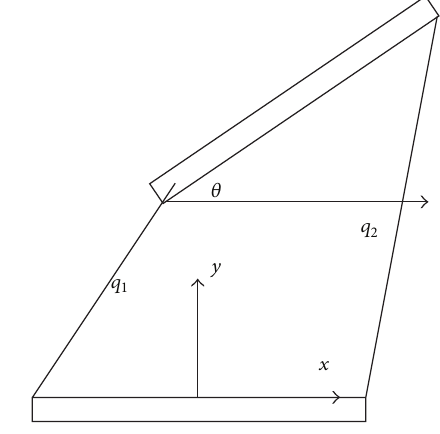
Figure 11: 2D representation of the model.